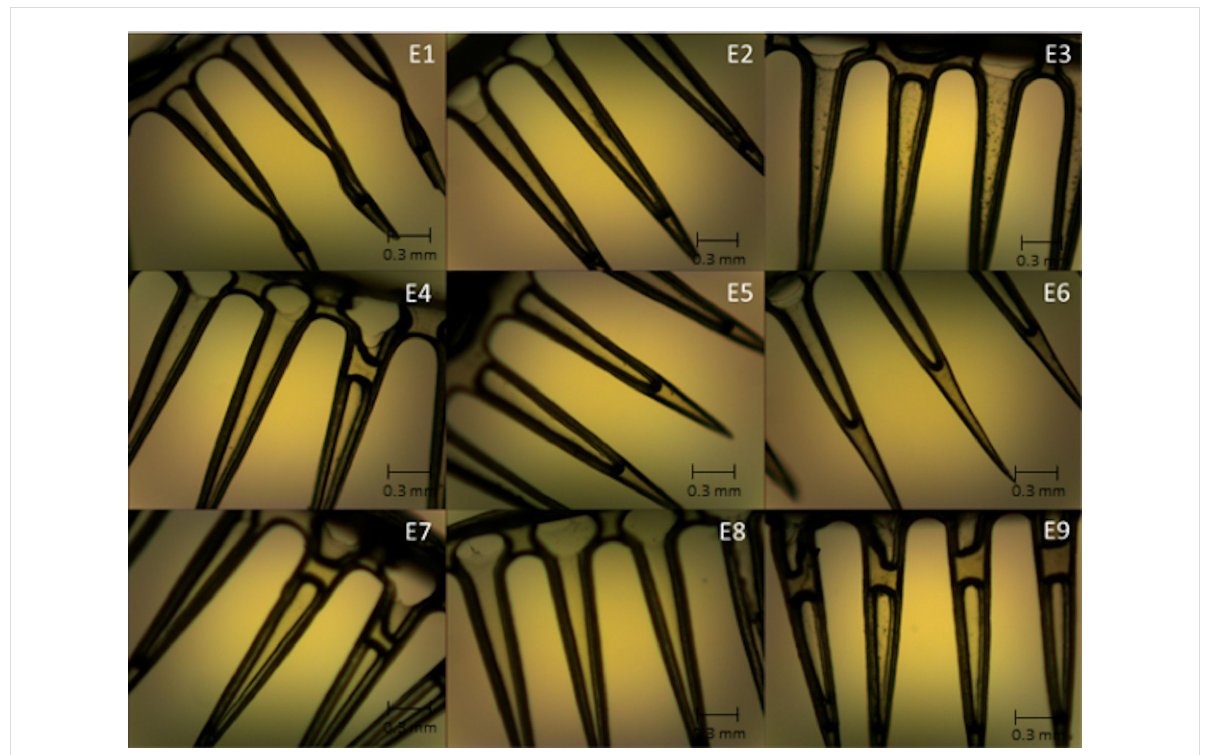
Figure 1: Micrographs obtained by optical microscopy showing the structure of the microneedles containing ethanolic extract of propolis (E1 to E9); magnification 40×.